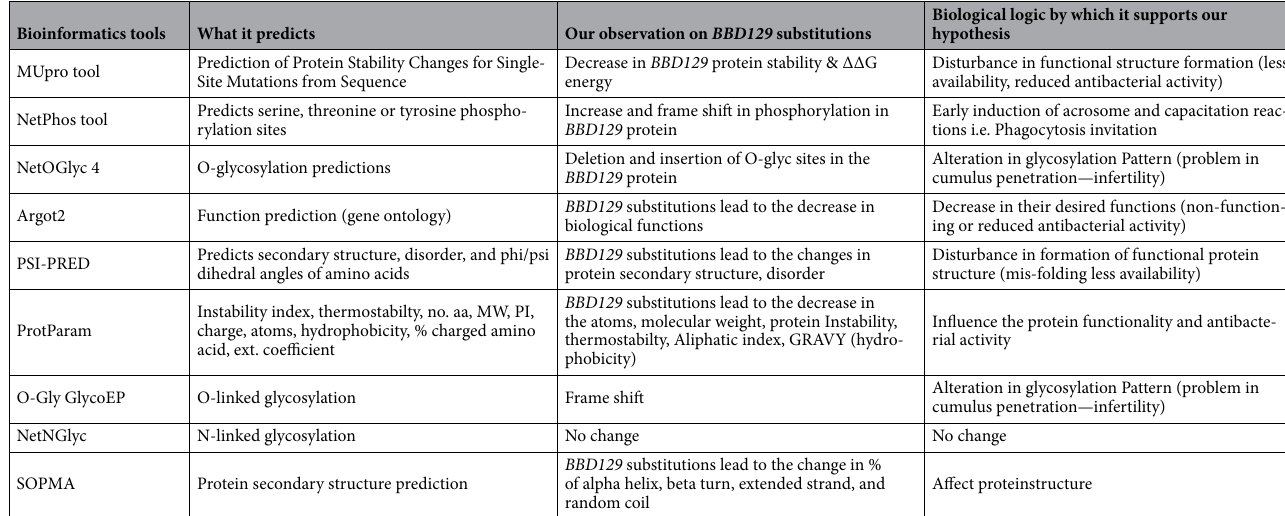
Table 4. The overall conclusions of various bioinformatics tools used for the analyses of impact of polymorphisms on BBD129